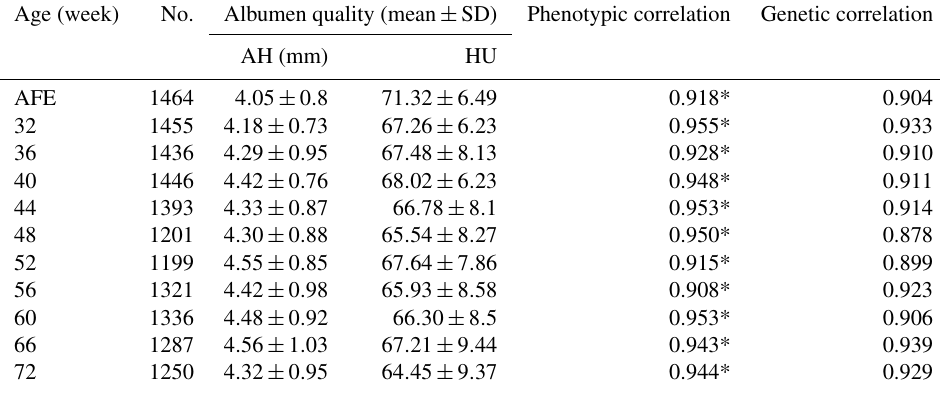
Table 1. Phenotypic data of albumen quality.